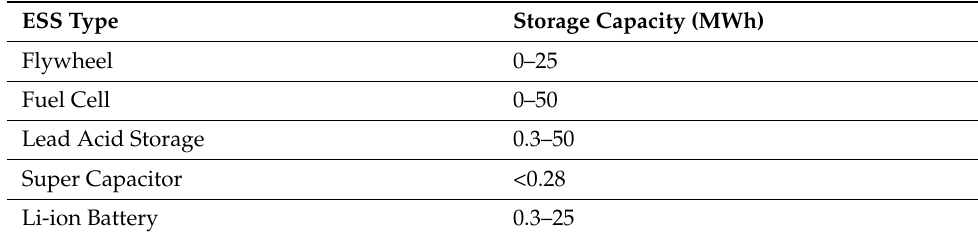
Table 5. Energy storage capacities of different devices for